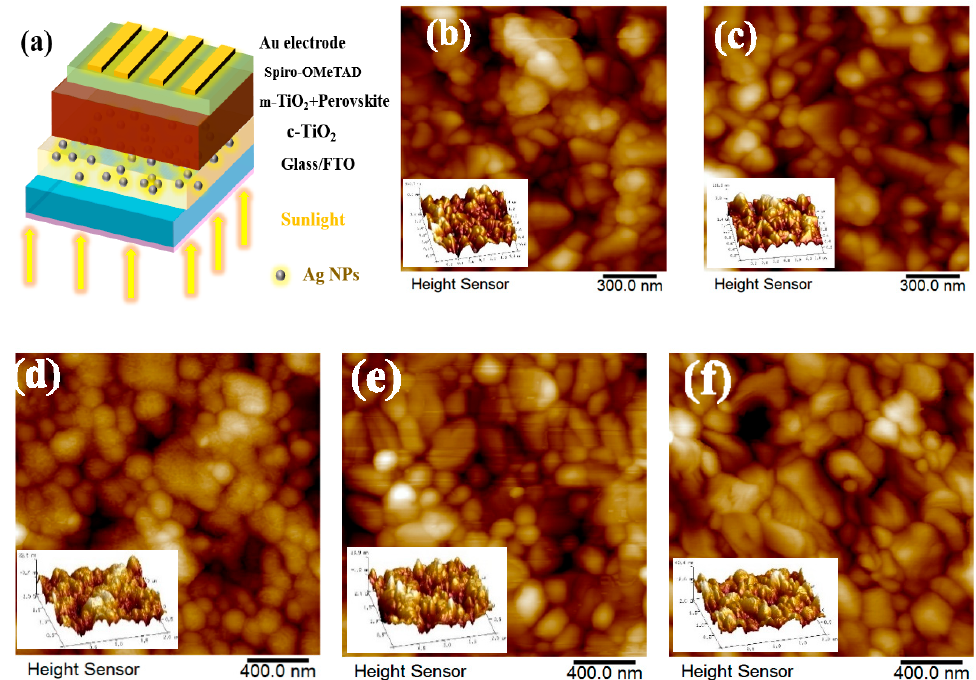
Figure 3. ( a ) Illustration of device structure labeled with different components. Surface morphologies of Atomic Force Microscopy (AFM) images of the S-FTO, T-FTO, perovskite/m-TiO 2 /c-TiO 2 /S-FTO, perovskite/m-TiO 2 / with Ag NPs concentration of 10 wt.% embedded in c-TiO 2 /S-FTO or T-FTO in ( b ), ( c ), ( d ), ( e ) and ( f ), respectively.